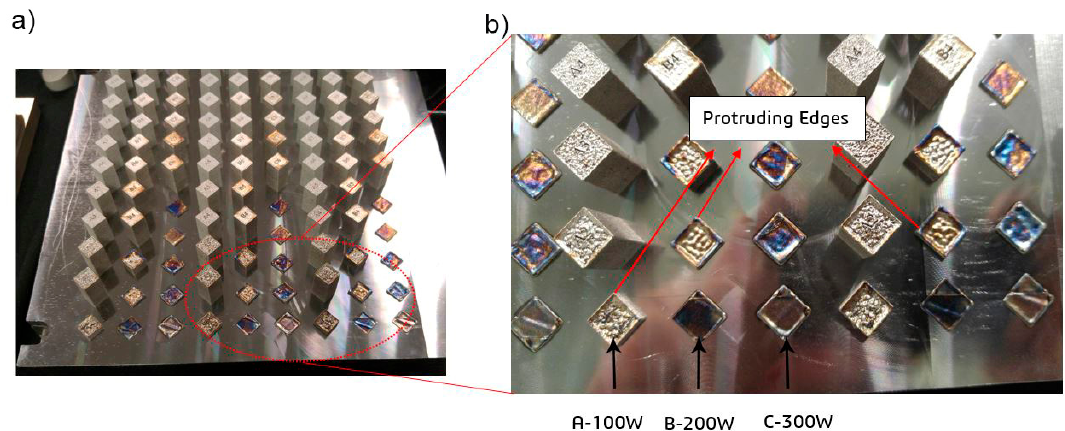
Figure 4. SLM-processed samples: ( a ) Failed parts are within the red ellipse; and ( b ) protruding edges of the failed parts.